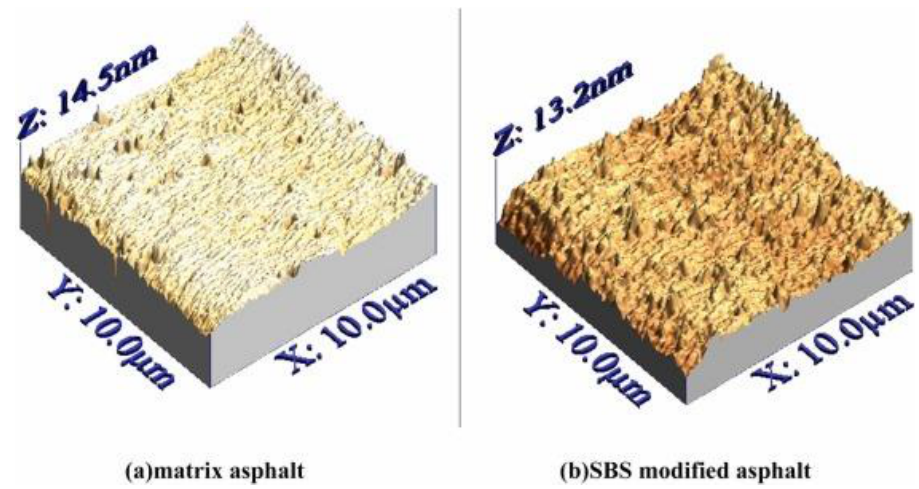
Figure 7. The bee phases of the matrix asphalt and SBS modified asphalt. Reproduced with permission of [93]. © 2022 Elsevier Ltd.